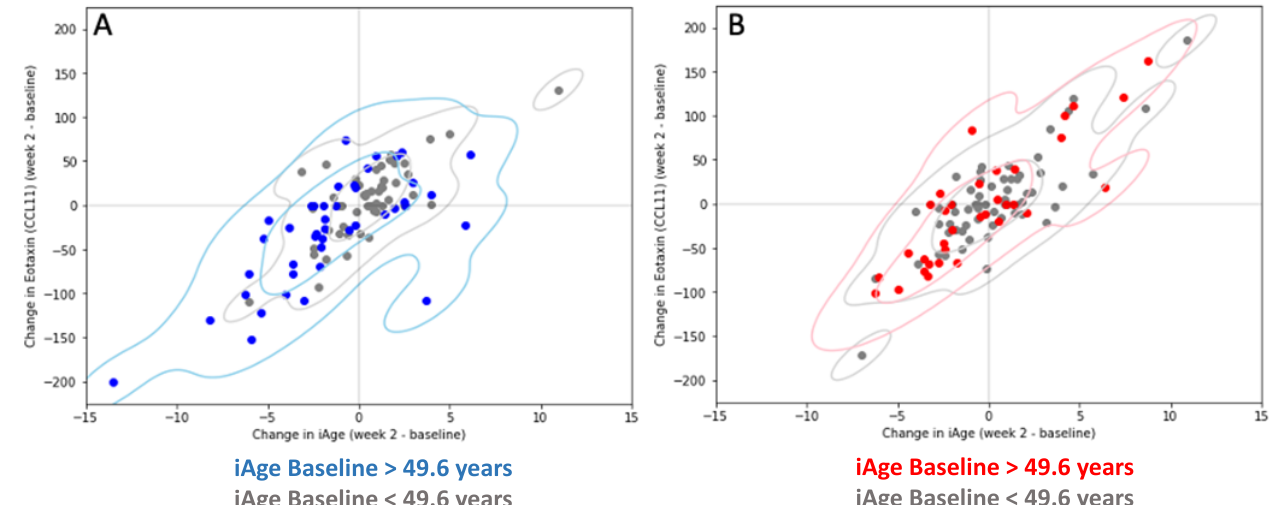
Figure 4. Effects of CCL11 changes on iAge ® . The change in iAge ® between baseline and week 2 (x-axis) is compared to the change in CCL11 between baseline and week 2 (y-axis) for each patient. Individuals were stratified based on a high baseline iAge ® (blue circles) or low baseline iAge ® (grey circles). ( A ) Those in the oat group and have a high baseline iAge ® trend towards a lower iAge ® at week 2 and lower CCL11 level. ( B ) Those in the placebo group have no decreasing or increasing iAge ® or CCL11 level trends.